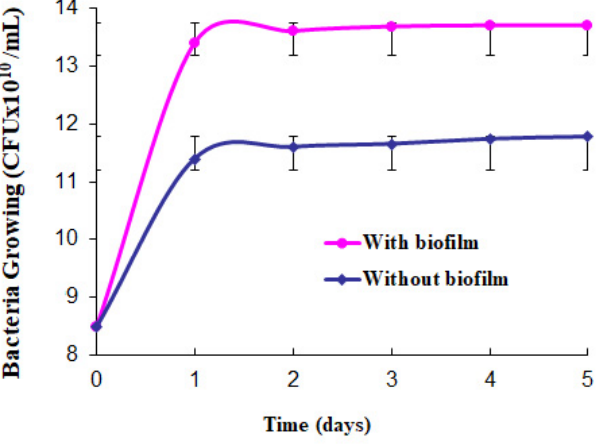
Figure 7. Bacterial growth during the Lignin removal.